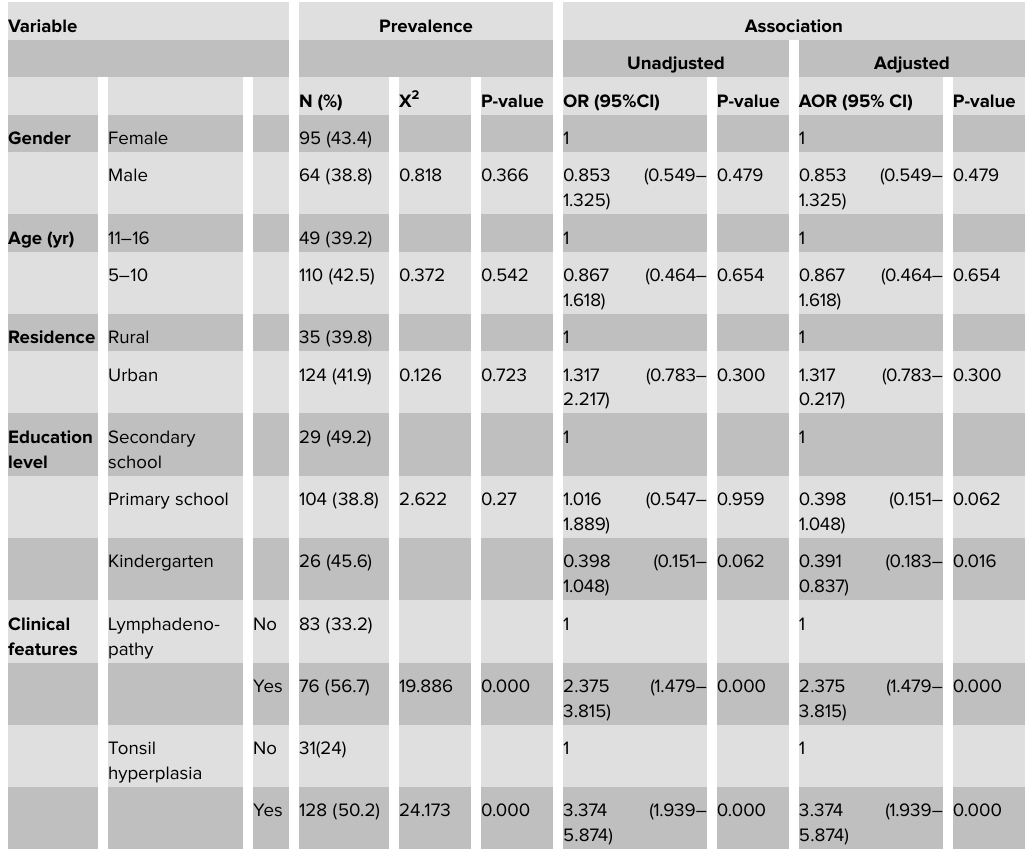
Table 3: Association of streptococcal sore throat with gender, age groups, residence, and clinical features of